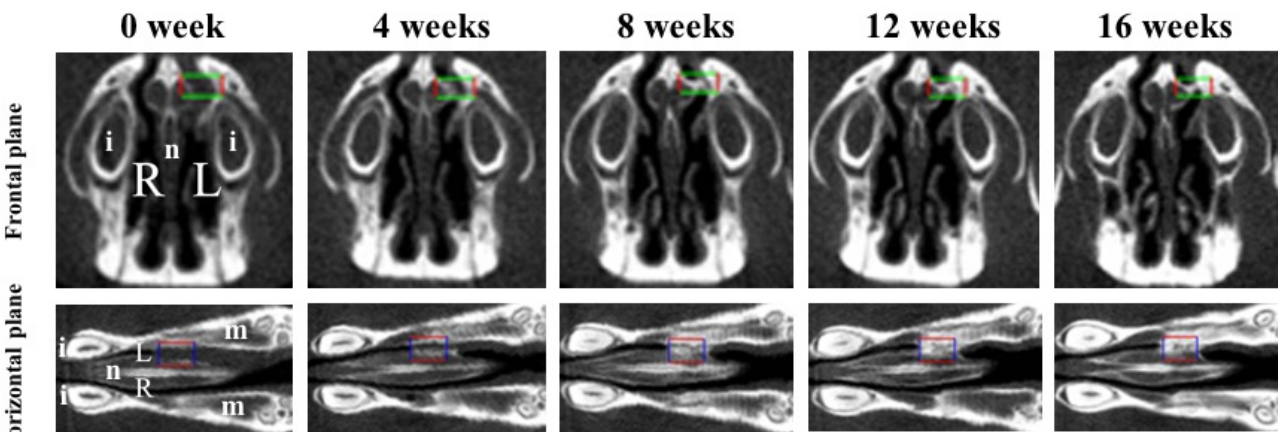
Figure 2. Two viewpoints of micro-CT images of the palatine fissures in the frontal plane and the horizontal plane. Box areas in the frontal plane and the horizontal plane show the palatine fissures in palates of rats. Radiological analysis performed in approximately the same place (box area) at the anatomical location using the regions of interest (ROIs) before grafting (0 week) and 4, 8, 12 and 16 weeks after grafting. The size of ROI is 1.8 × 2.7 × 0.9 mm 3 (box areas). i: incisor. L: The left palatine fissure (graft side). m: molars. n: nasal septum. R: The right palatine fissure (non-graft side).